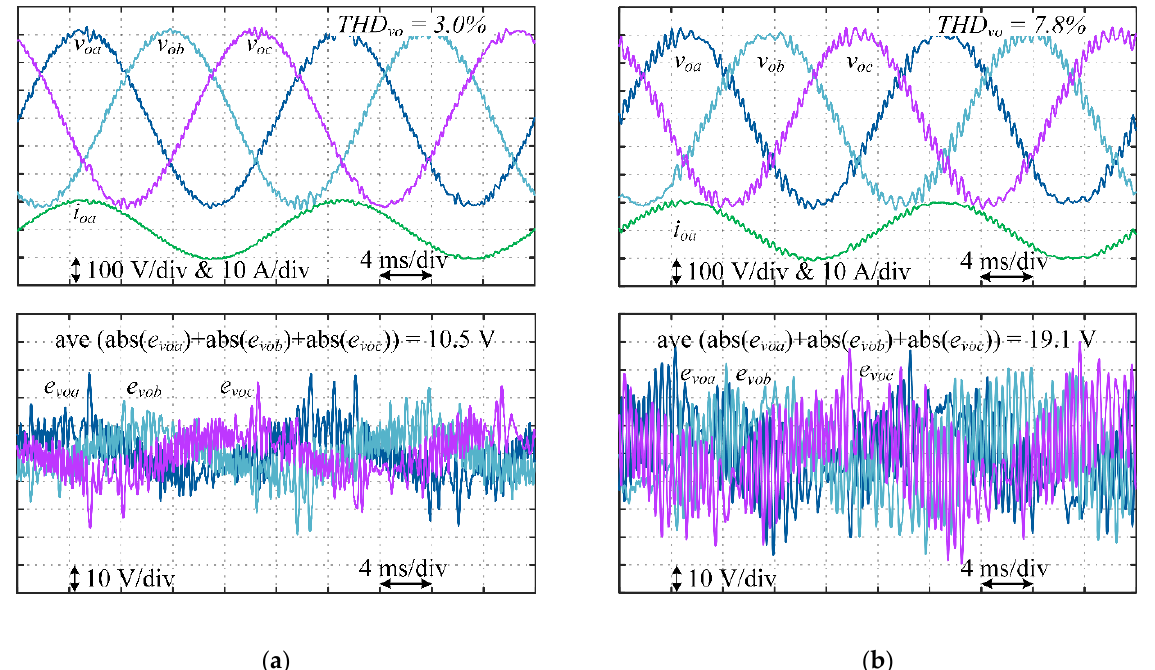
Figure 6. Simulation results showing steady-state performance under nominal load (5 kW) and 75% error in the initial value of filter capacitance ( e C = 75%), ( a ) the proposed adaptive MPC, ( b ) conventional MPC.